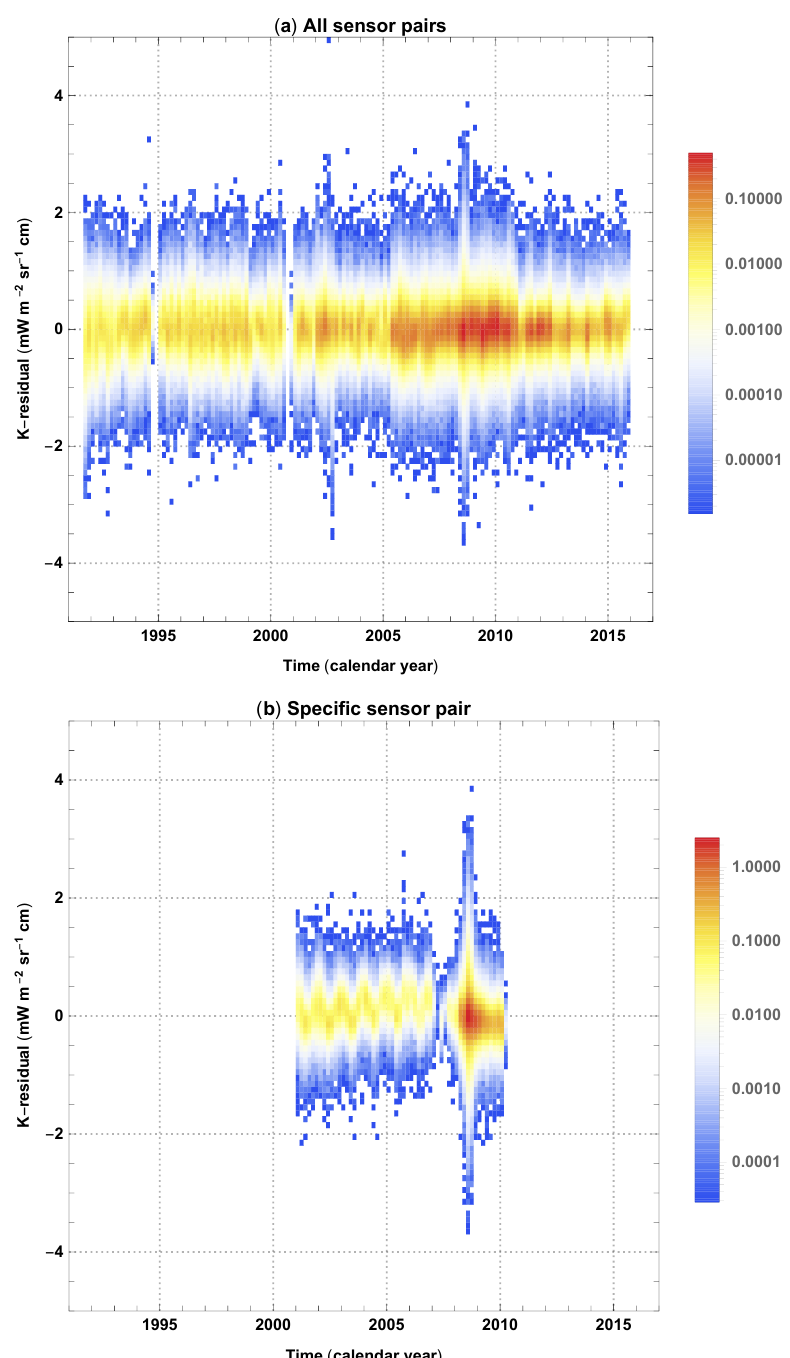
Figure 6. Probability density (indicated by logarithmic colour scale) of harmonised K -residuals over time. ( a ) top panel: for all sensor pairs; ( b ) bottom panel: for a specific sensor pair (here NOAA-16 and